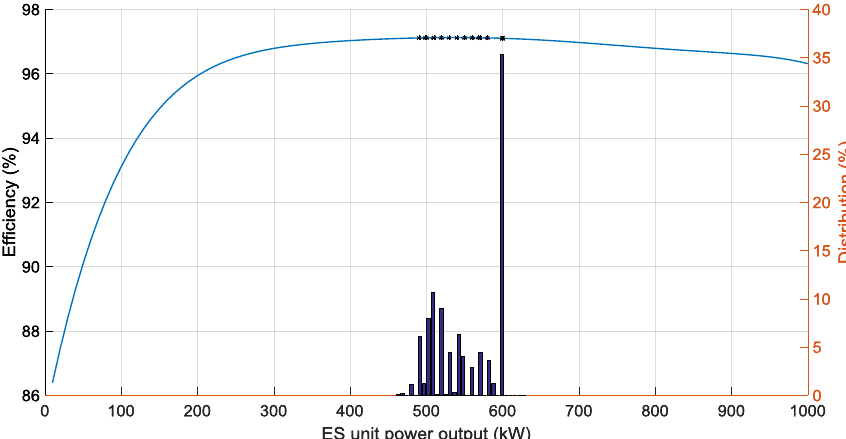
Figure 12. ESU operation efficiency and distribution according to the optimally assigned power.